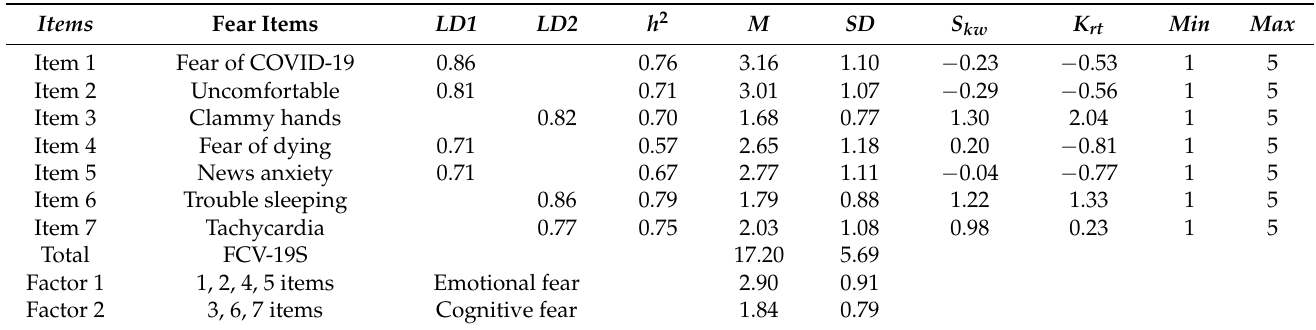
Table 2. FCV-19S EFA